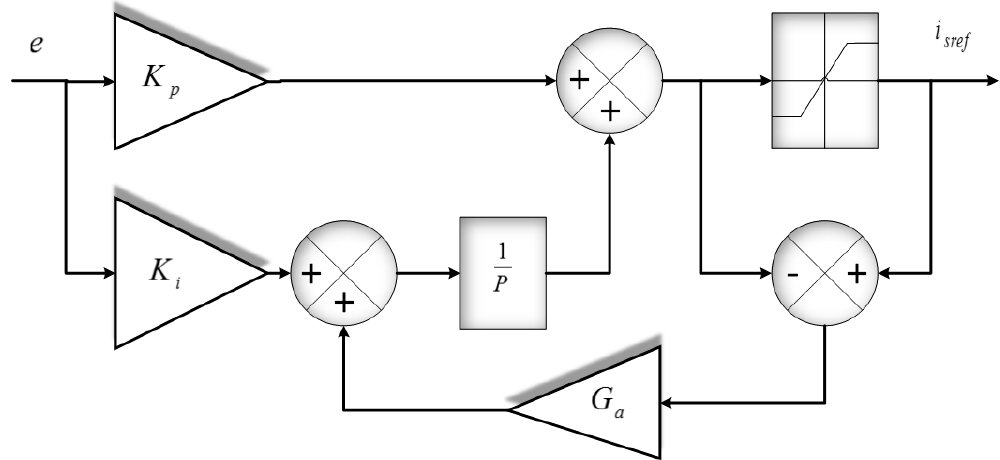
Figure 4. Block diagram of proportional integral controller joined with anti-windup gain.